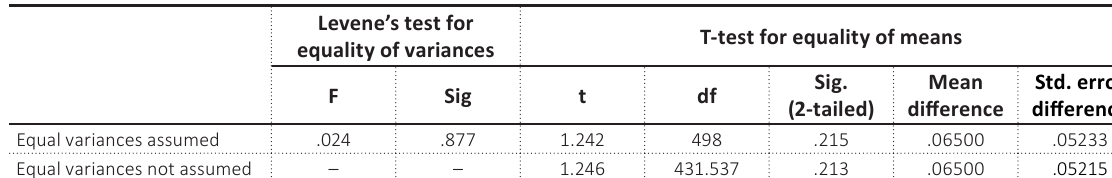
Table 8. Results of testing the difference between the two groups of managers and auditors